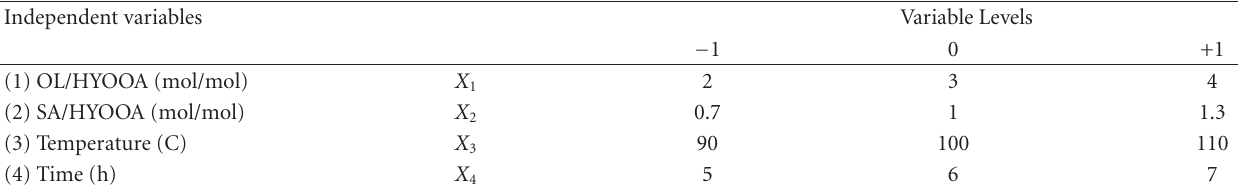
Table 1: Independent variables and their levels for D-optimal design of the esterification reaction. Independent